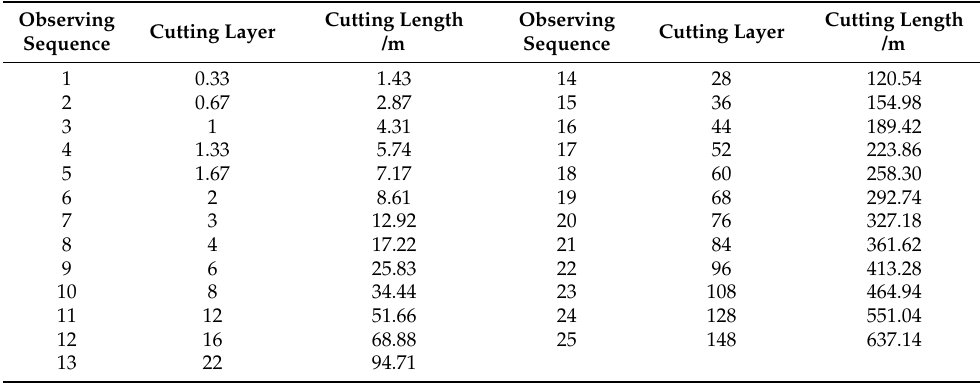
Table 3. The arrangement of tool wear